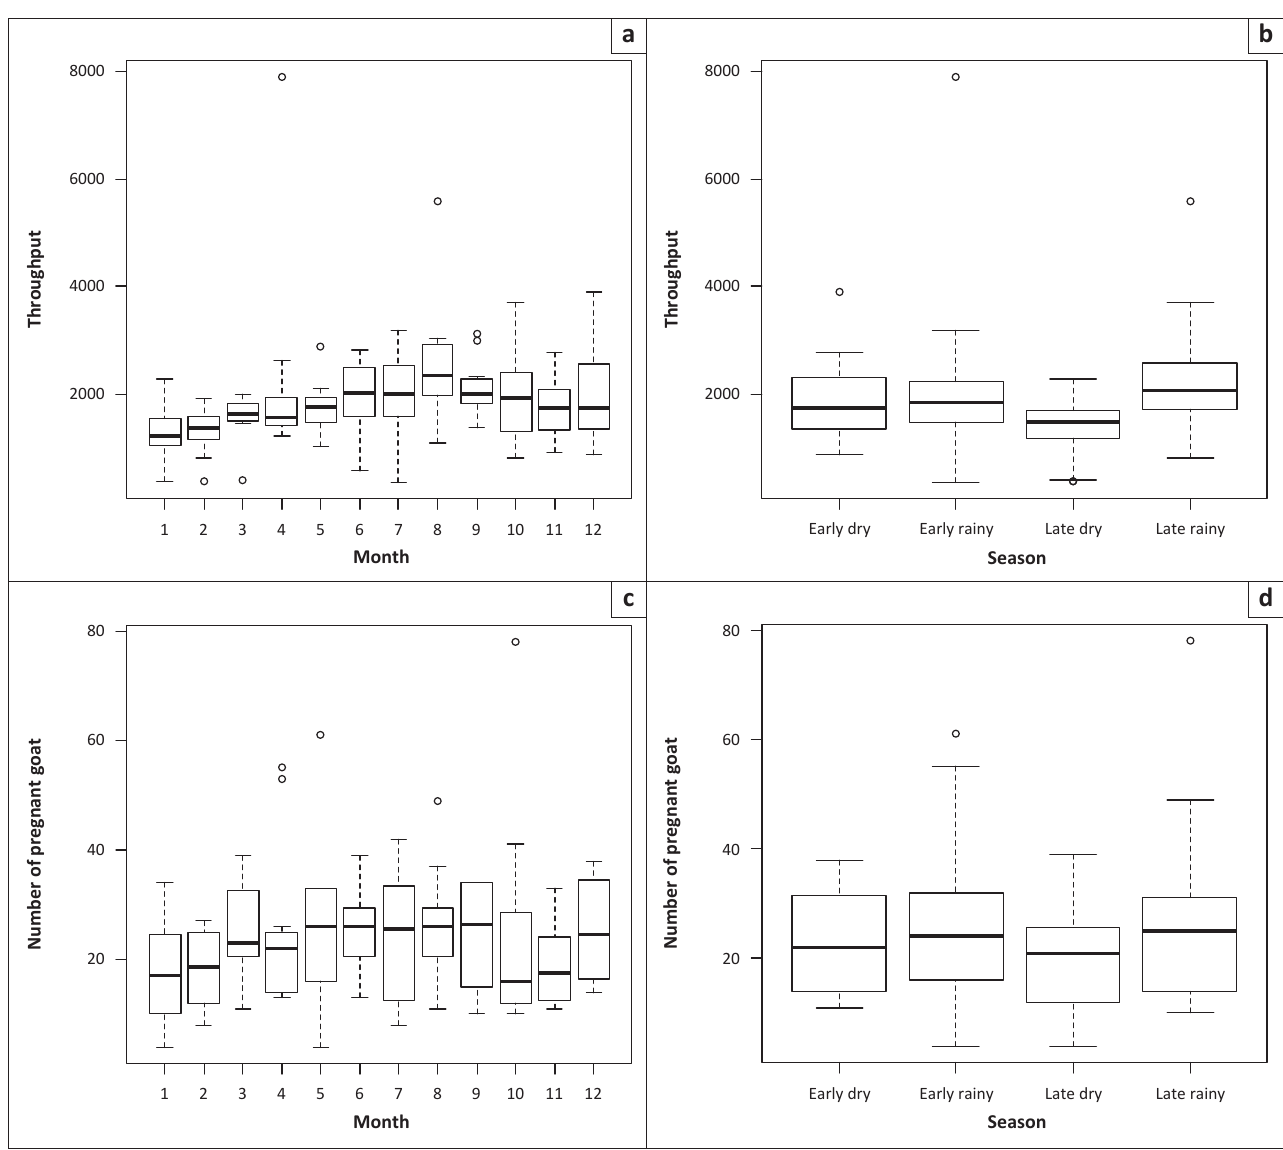
FIGURE 3-A2: Monthly and seasonal rate of throughput, slaughter of pregnant animals and foetal wastage for goats, Minna Metropolitan Abattoir, Nigeria, during 2001– 2012. (a) Monthly throughput for goat, (b) seasonal throughput for goat, (c) monthly slaughter of pregnant goat, (d) seasonal slaughter of pregnant goat, (e) monthly rate of foetal wastages in goat and (f) seasonal rate of foetal wastages in goat.